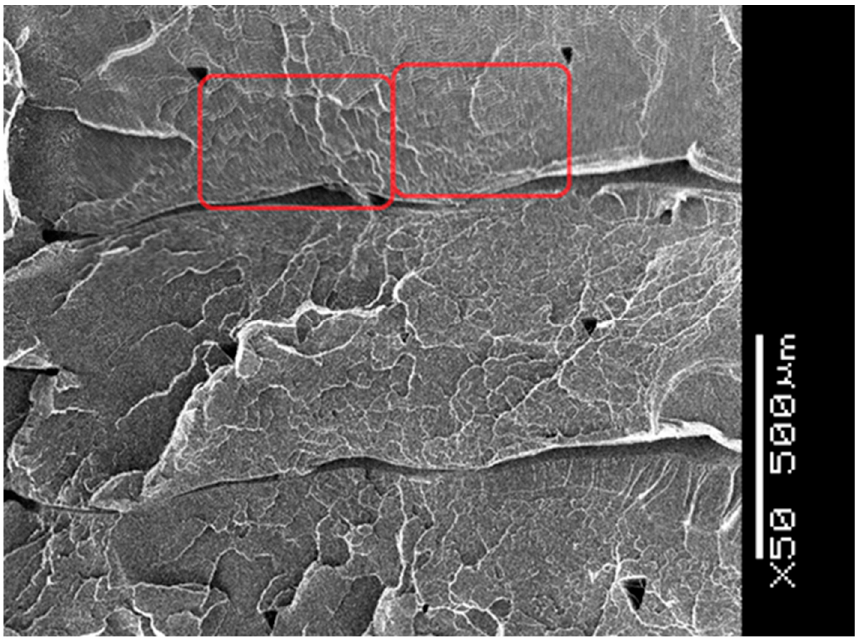
Figure 11. SEM picture of a specimen produced with 0.3 mm layer thickness.